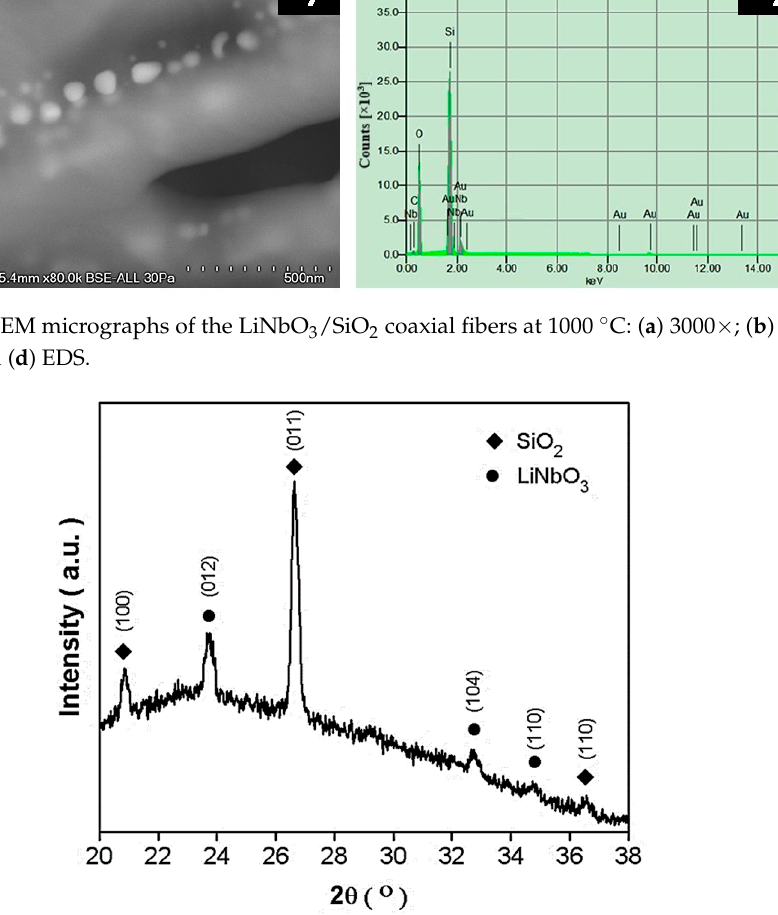
Figure 7. The XRD of the LiNbO 3 /SiO 2 coaxial fibers at 1000 °C.